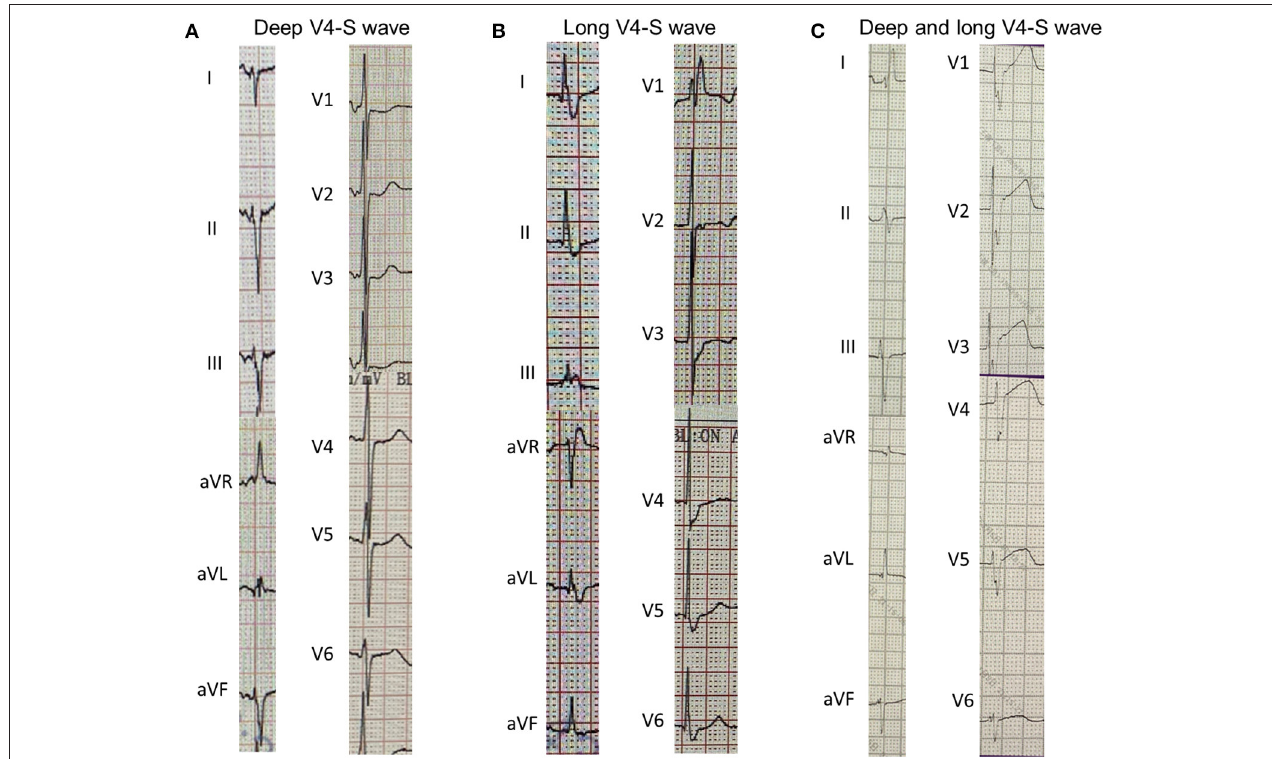
FIGURE 1 | Three cases of long or deep V4-S wave in 12-lead electrocardiogram. (A) , V4-S wave depth > 0.6mV; (B) , V4-S wave duration > 50ms; (C) , V4-S wave is wide and